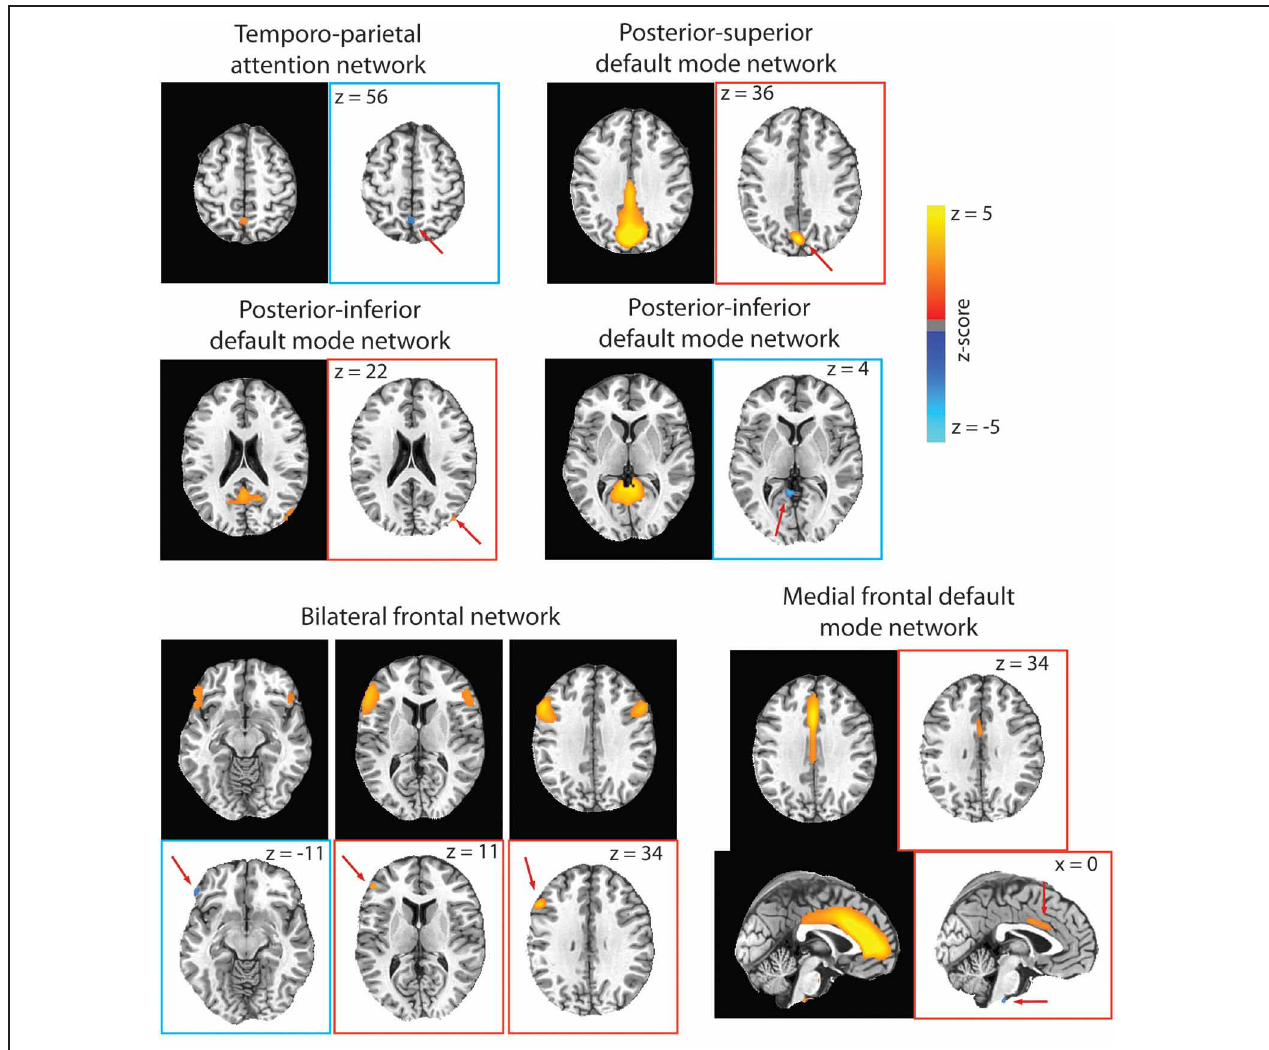
FIGURE 5 | For each RSN that had significant para-ICA correlations, the RSN from our group ICA is displayed on black background, while the spatial component resulting from the para-ICA is displayed on white background. Spatial components with blue borders represent components